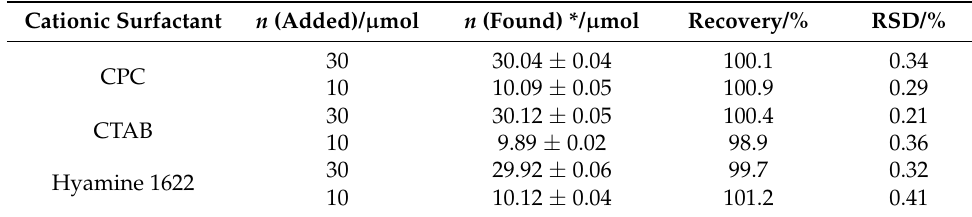
Table 4. Potentiometric titration of CPC, CTAB, and Hyamine 1622 cationic surfactant solu- tions using the standard addition method. DDS was used as a titrant (4 × 10 − 3 M) (mean values ± 95% confidence